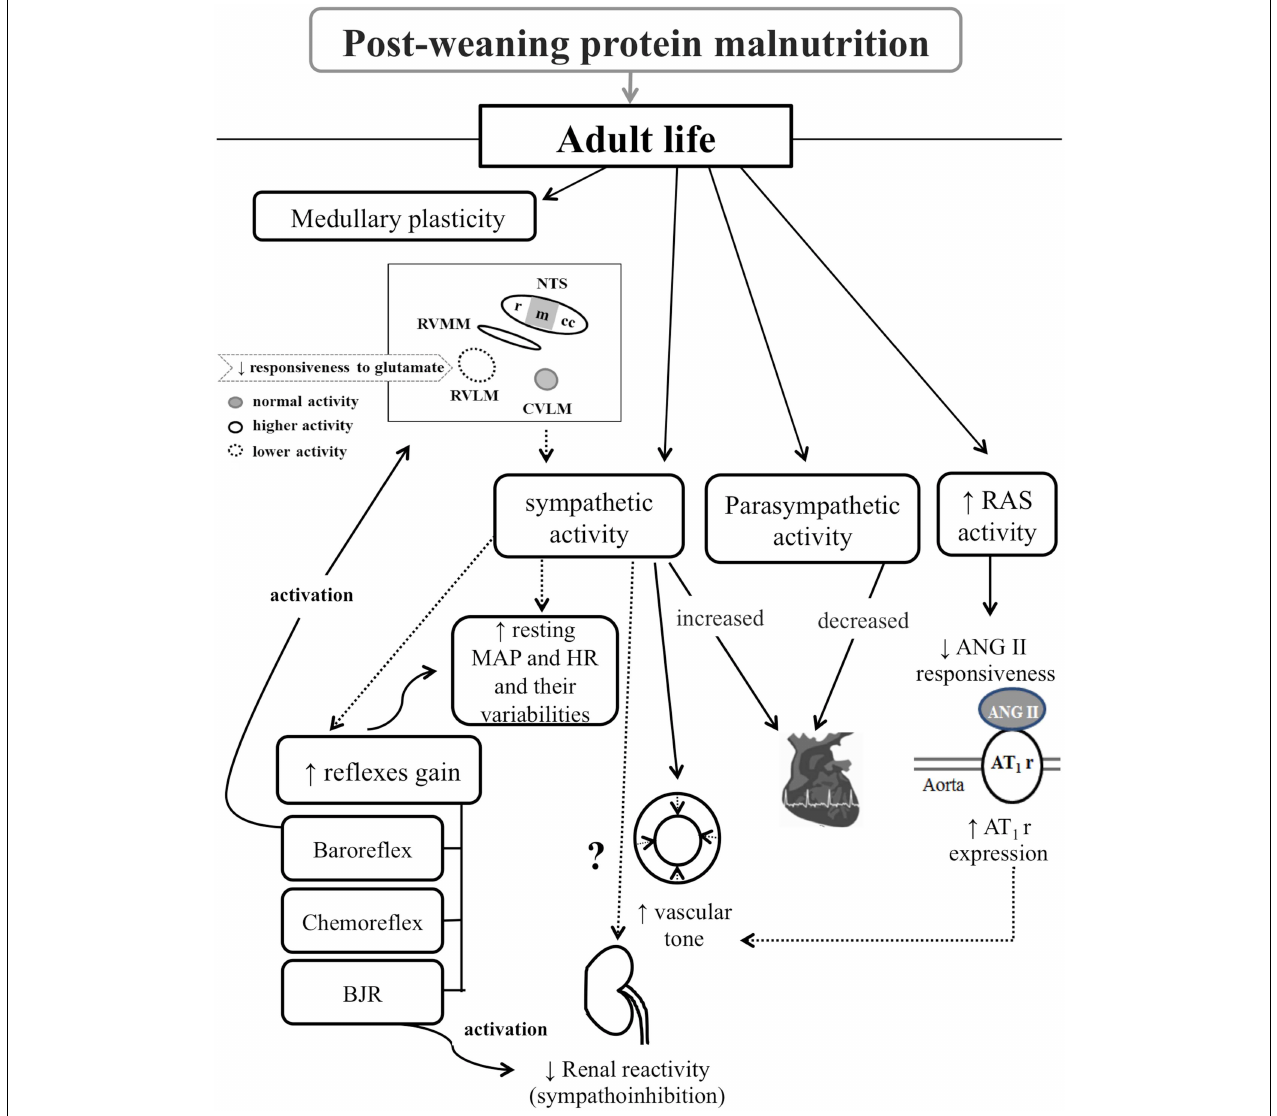
FIGURE 1 | Diagram illustrating the post-weaning protein malnutrition effects on cardiovascular control systems in adult rats. Rectangles and black arrows correspond to data observed in this malnutrition model. Dashed arrows correspond to likely interaction between observed data. From left to right, protein restriction promotes: medullary plasticity, vasomotor and cardiac sympathetic overactivity, decreased cardiac parasympathetic activity, and RAS hyperactivity. The neuroplasticity is characterized by changes in medullary recruitment in response to baroreflex stimulation, and decreased glutamate responsiveness in the RVLM. Such medullary plasticity probably contributes to the sympathetic overactivity. This, in turn, relates to the impaired cardiovascular reflexes sensitivity, increased resting MAP and HR and their variabilities, and plausible shift in baseline renal sympathetic activity in view of the reduced renal sympathoinhibition to BJR activation. The RAS hyperactivity associates with the low ANG II responsiveness and high aortic AT 1 r expression, which probably contribute to increased vascular tone. RAS, renin-angiotensin system; MAP, mean arterial pressure; HR, heart rate; BJR, Bezold–Jarish reflex; ANG II, angiotensin II; AT 1 r, angiontensin II receptor type 1; NTS, nucleus tractus solitary; rNTS, rostral NTS; mNTS, medial NTS; ccNTS, caudal-commissural NTS; RVMM, rostral ventromedial medullary areas; RVLM, rostral ventrolateral medullary area; and CVLM, caudal ventrolateral medullary